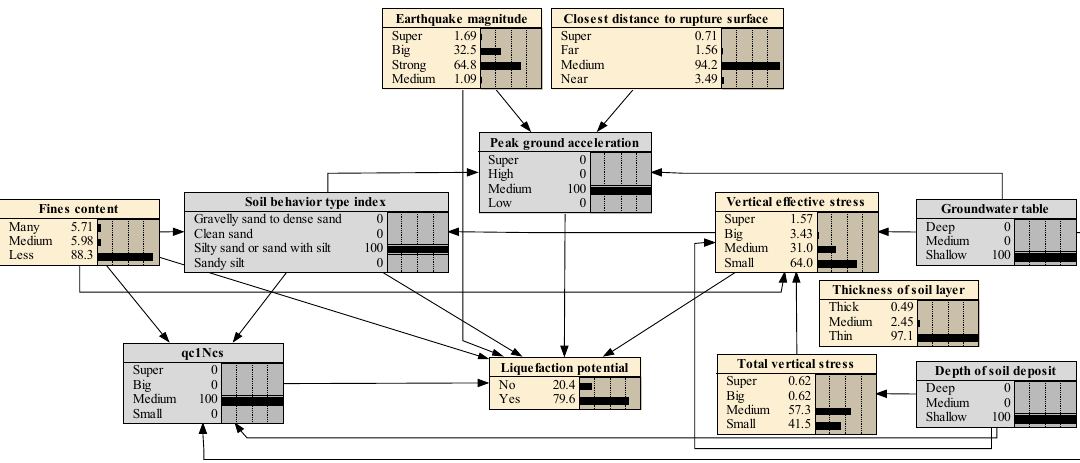
Figure 6. Liquefaction potential prediction when the state of evidence variables are “ PGA = medium,” “ D w = shallow,” “ I c = silty sand or sand with silt,” “ q c 1 Nc s = medium,” and “ D s = shallow.” (II) Causal Inference